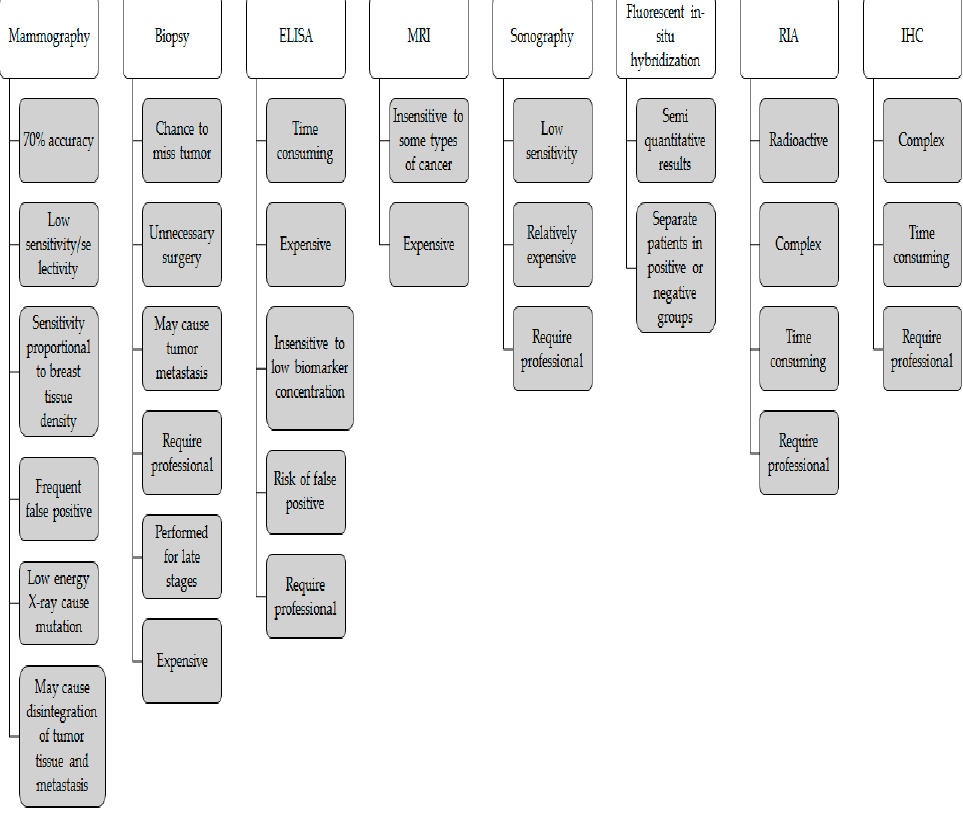
Figure 4. Disadvantages of the techniques used for breast cancer (BC) screening.[8].